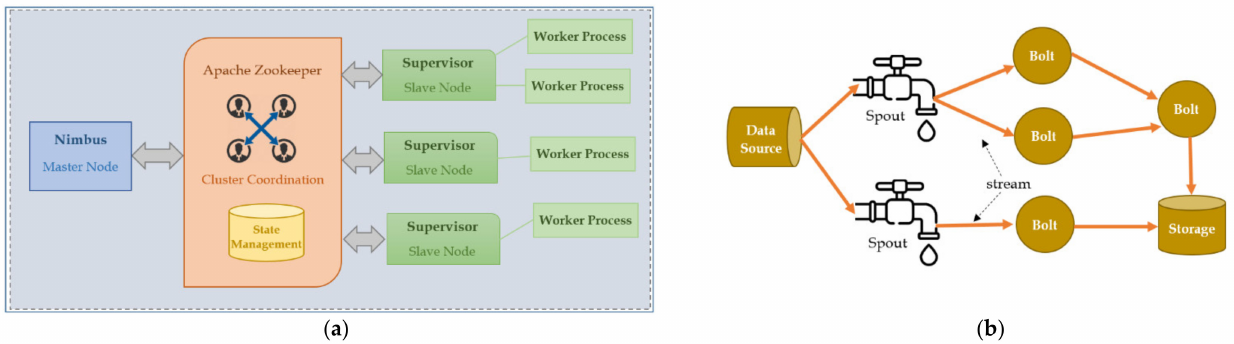
Figure 7. Apache Storm ( a ) Architecture of Apache Storm; ( b ) An illustration of Storm